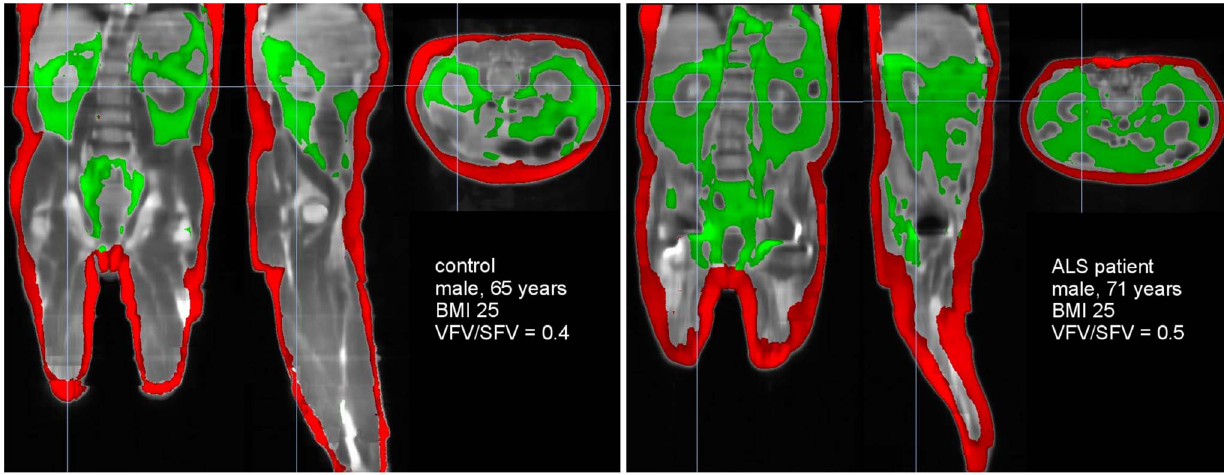
Figure 1. Comparison of fat deposits of an ALS patient and a control. Fat volume determination in a control (BMI=25 kg/m 2 ) (left) and in an ALS patient (BMI=25 kg/m 2 ) (right). Subcutaneous fat tissue is coloured in red, visceral fat tissue is coloured in green.